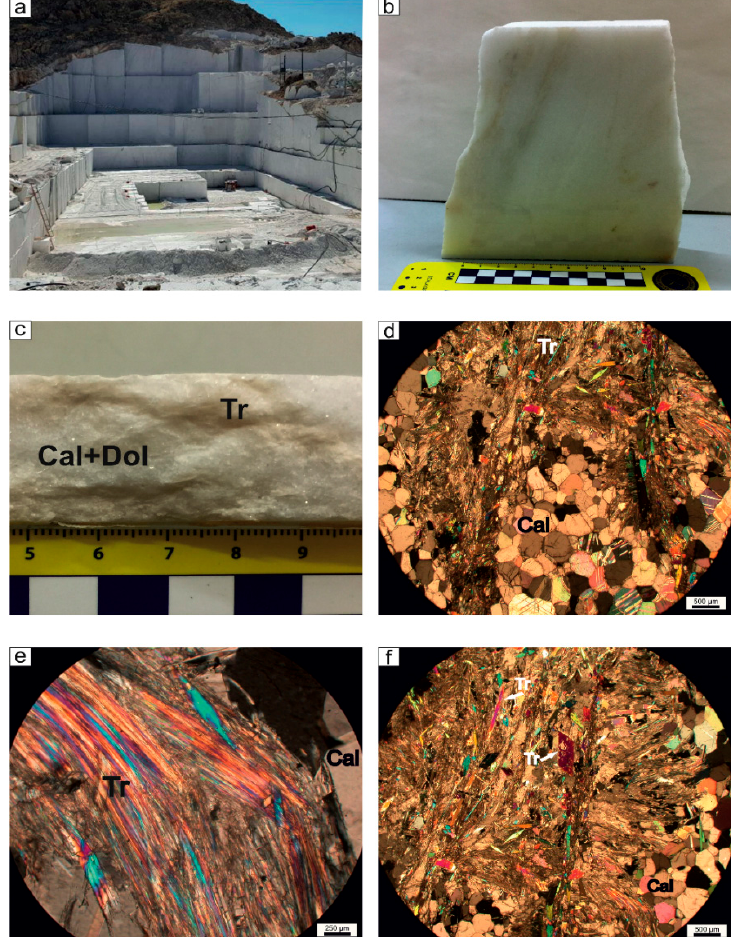
Figure 3. The main features of Karibib white marbles. ( a ) Front of a quarry where marble is exploited as dimensional stone; ( b ) Appearance of the marble at the mesoscopic scale, note the yellow-greenish veins across the pearly portion; ( c ) Particular of a cross section of a brick; ( d – f ): Photomicrographs of thin sections of marbles; ( d ) Coexistence of granoblastic portions constituted by calcite with nematoblastic portions constituted by tremolite; ( e ) Blow-up of acicular tremolite-rich level; ( f ) Nematoblastic level showing various habitus types of tremolite, from prismatic to acicular. Mineral symbols after [50].